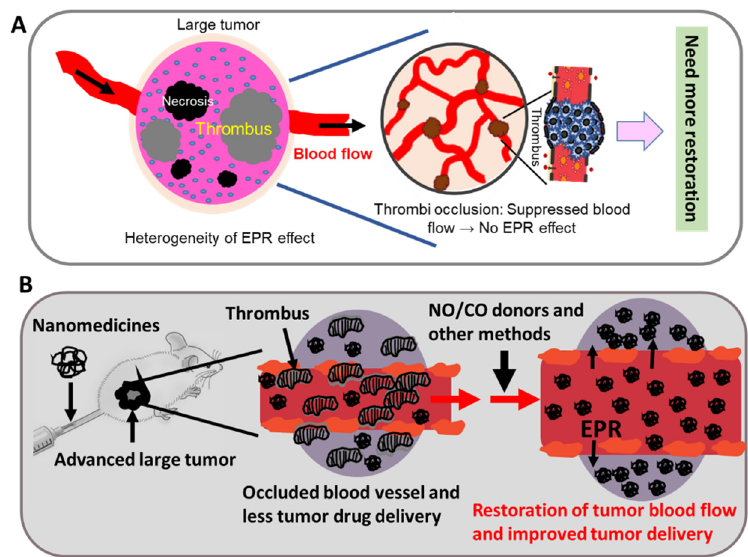
Figure 2. Illustration of an embolized blood vessel in an advanced tumor ( A ) and the strategy used to overcome the suppressed blood flow ( B ). Late-stage tumors possess many necrotic areas, and a fibrin clot resulted in thrombus formation, which blocked tumor blood flow ( A ). In this case no typical enhanced permeability and retention (EPR) effect existed, and additional enhancement of tumor blood flow was needed. ( B ) Mechanism of tumor blood flow restoration by using different methods or EPR effect enhancers.